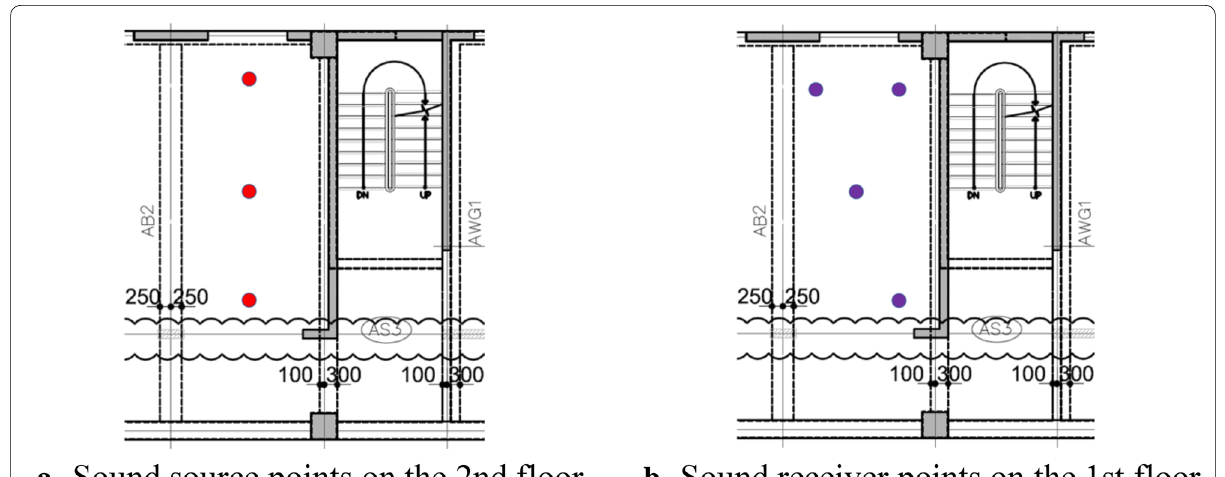
Fig. 4 Sound sources and receiver points.